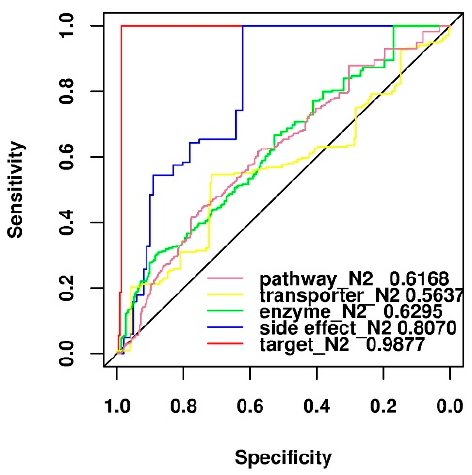
Figure 6. Performance comparison of five different feature types for the N2 negative data set by using our feature selection and improved naïve Bayesian method in the leave-one-out cross validation test.